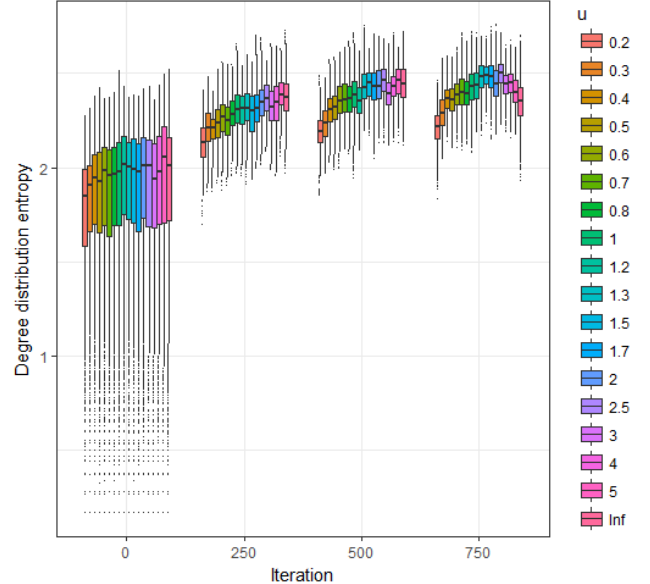
Figure 4. Estimated expected value of the sample degree distribution entropy as function of u at iterations 250, 500, 750 and